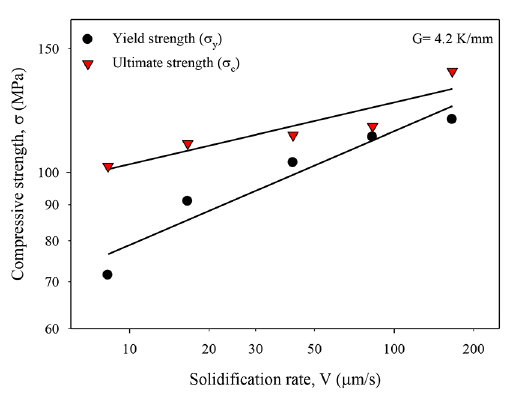
Figure 9. Variation of compressive strength of the Sn-36Bi-22Cu alloy as a function of solidification